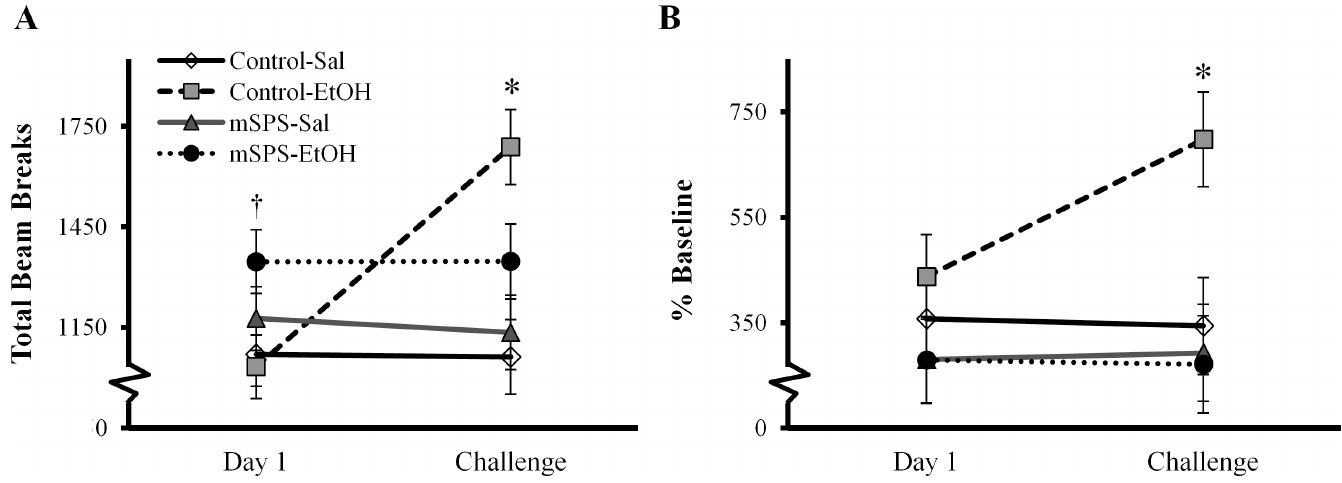
Fig 3. Mice exposed to mSPS followed by chronic EtOH (mSPS-EtOH) demonstrate impaired EtOH-LMA sensitization. * p < 0.05 Control-EtOH mice on challenge compared to Control-Sal on Day 1, as well as Control-Sal and mSPS-EtOH on Challenge. † p < 0.05 mSPS-EtOH mice compared to Control- EtOH mice on Day